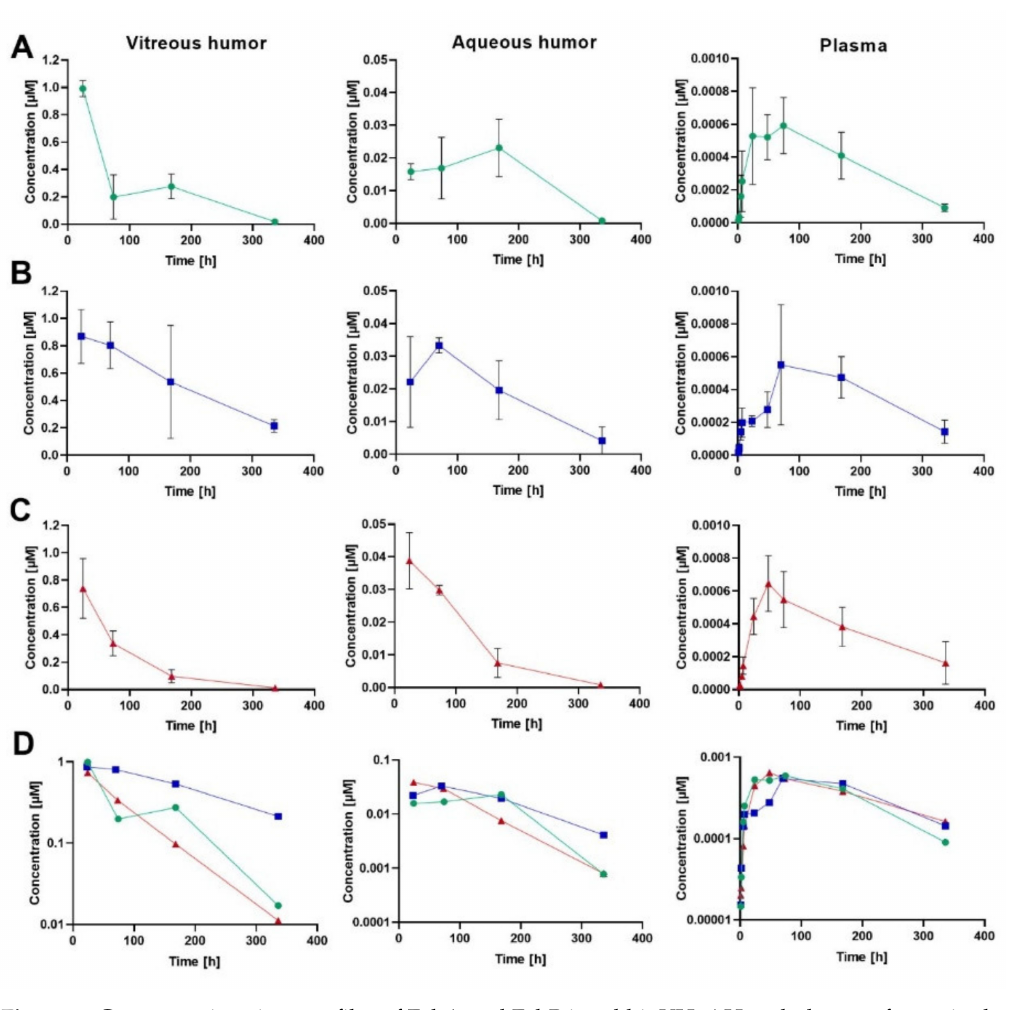
Figure 2. Concentration-time profiles of FabA and FabB in rabbit VH, AH and plasma after a single IVT injection of 0.05 mg per eye of the respective molecule co-formulated with HSA. Panel ( A – C ) represent the concentrations obtained in each matrix for group 1 (FabA and 1 nmol HSA), group 2 (FabA and 15 nmol HSA) and group 3 (FabB and 1 nmol HSA), respectively. Composite data are plotted as mean ± S.D. Panel ( D ) depicts overlaid semi-log profiles of group 1, 2 and 3 without error bars for greater